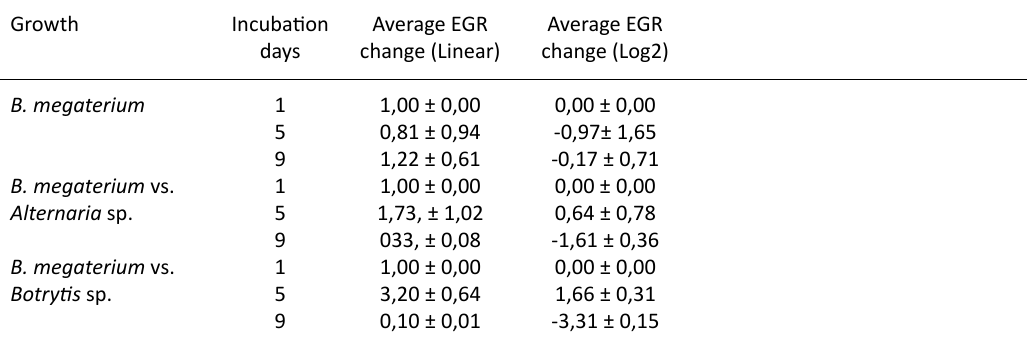
Table 3. Change in relative gene expression (RGE) of ITUDI in Bacillus megaterium alone and against pathogens Growth